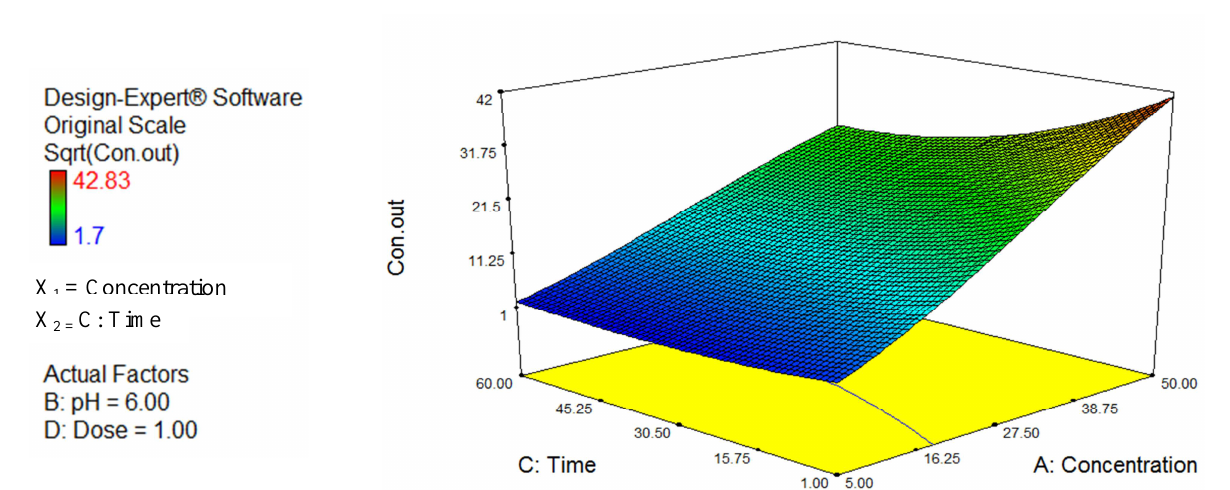
Figure 5. Response surface 3D plots showing effect of initial concentration (mg HA/l) and time on humic acid (HA) removal (mg/l)